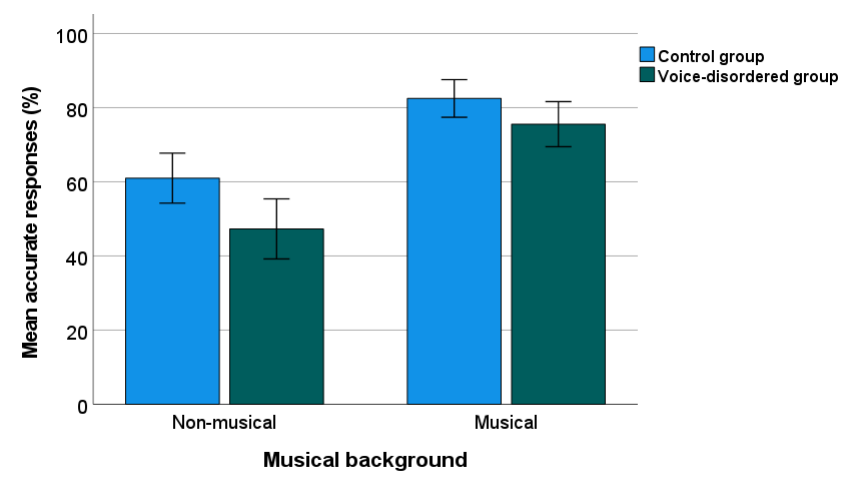
Figure 1. Percentage of PD accuracy in voice-disordered and control groups. Error bars indicate standard errors.